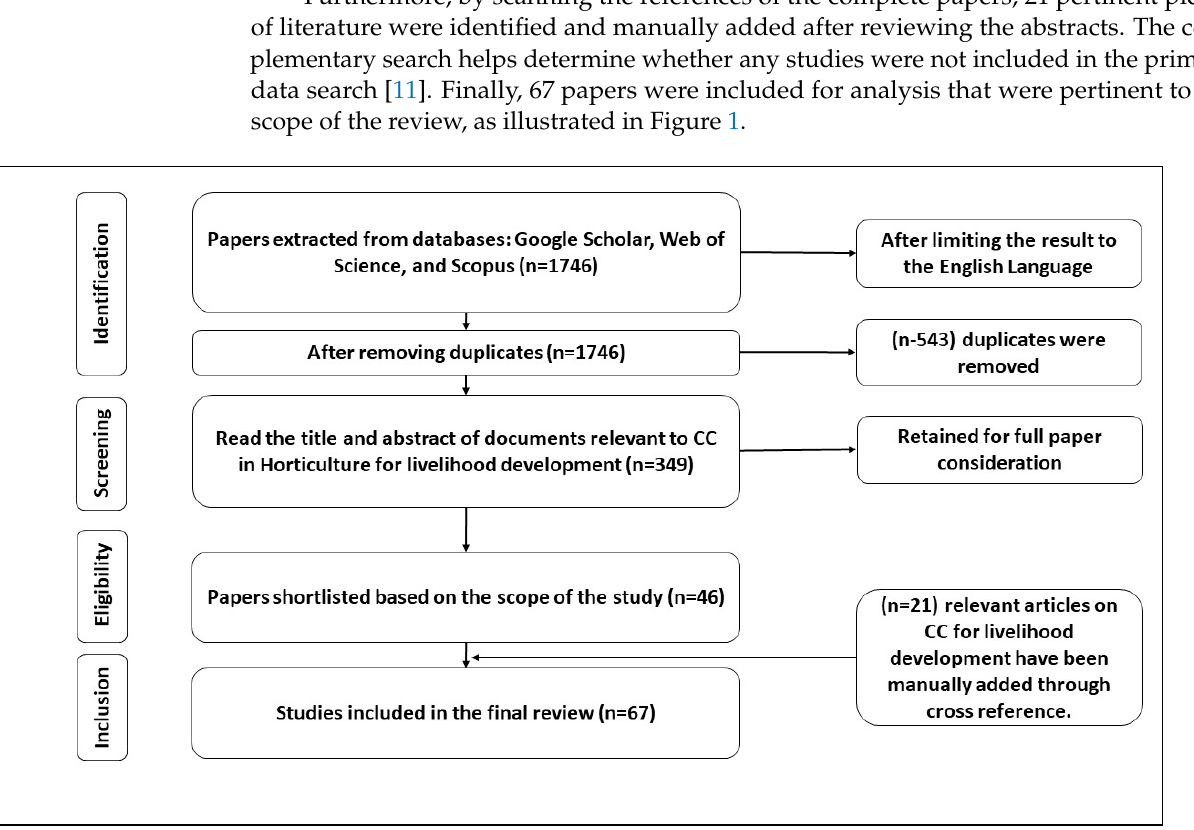
Figure 1. Search and Selection Criteria, Source: The Authors.